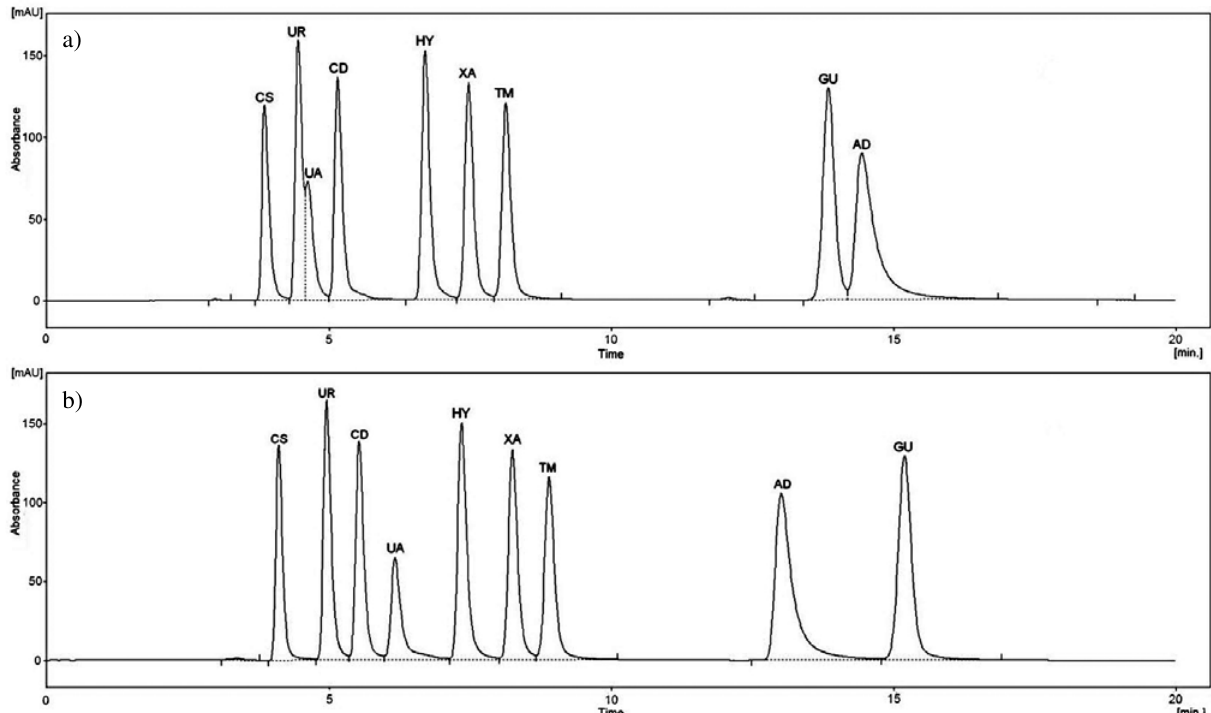
Figure 2 . Calculated buffer capacity at different pH for a) 0.10 M acetate and b) 0.05 M phosphate buffer.